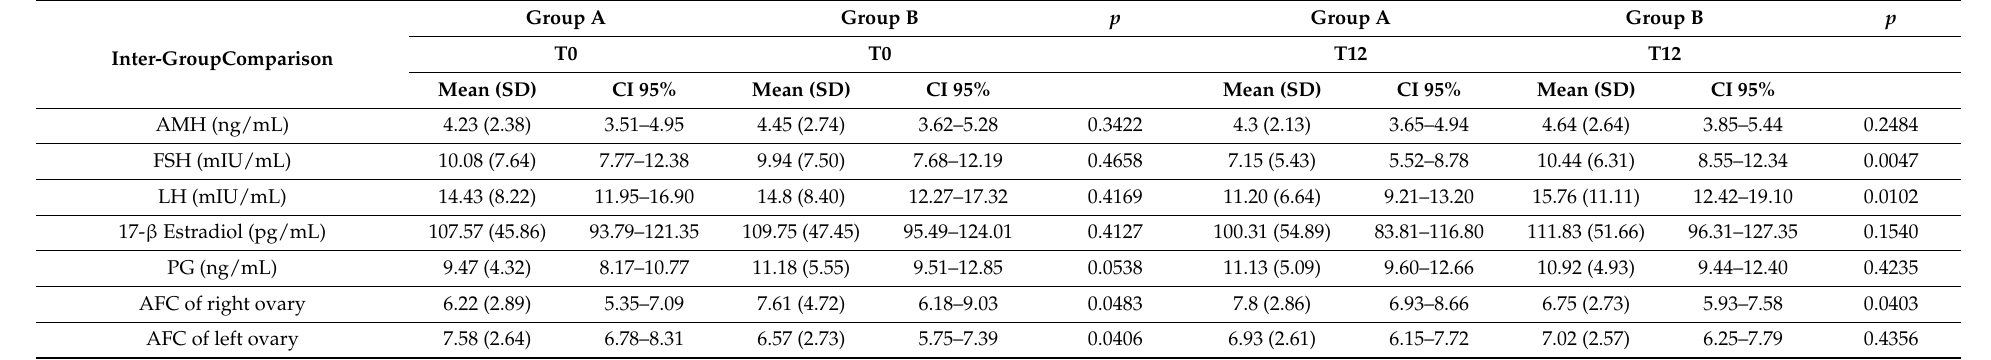
Table 3. Inter-group comparison of ovarian function parameters in long-term survivors of lymphoma at baseline (T0) and after 12 months